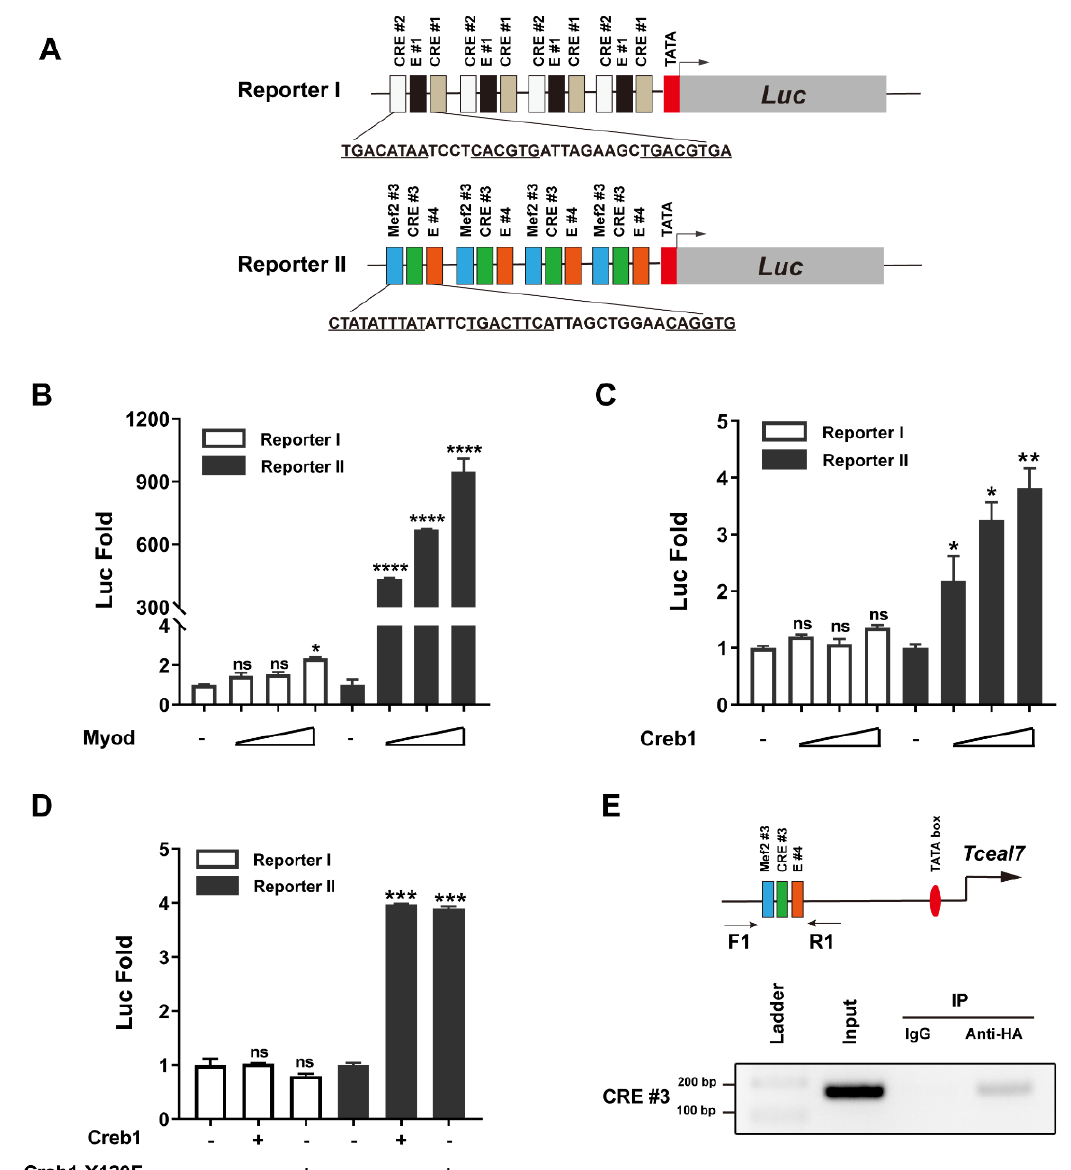
Figure 3. Transactivation of Tceal7 by Myod and Creb1. ( A ) Schematic illustration of Reporter I and Reporter II. Reporter I and Reporter II contain multimerized sequences from the Tceal7 promoter in a tandem manner: 4×(CRE#2–E#1–CRE#1) and 4×(Mef2#3–CRE#3–E#4), respectively. ( B ) Reporter I or Reporter II (400 ng) and Myod (200 ng, 400 ng and 600 ng) were cotransfected into the HEK293T cells, and analyzed with a dual-luciferase assay system. Myod can transactivate Reporter II up to 949-fold in a dose-dependent manner, while its transactivation of Reporter I is only 2.5-fold in HEK293T cells. * p < 0.05; **** p < 0.0001 and ns, not significant, comparison with first group (Reporter I or Reporter II). ( C ) Reporter I or Reporter II (400 ng) and Creb1 (200 ng, 400 ng and 600 ng) were cotransfected into the HEK293T cells, and analyzed with a dual-luciferase assay system. Creb1 can transactivate Reporter II up to 4-fold, but not Reporter I in HEK293T cells. * p < 0.05; ** p < 0.01 and ns, not significant, comparison with first group (Reporter I or Reporter II). ( D ) Creb1-Y120F or the wild-type Creb1 can transactivate Reporter II up to 4-fold, but not Reporter I in HEK293T cells. *** p < 0.001 and ns, not significant, comparison with first group (Reporter I or Reporter II). ( E ) Upper panel, ChIP primer design as in Figure 2D. Creb1 binds to the CRE #3 motif within the promoter of Tceal7 in C2C12 myotubes. All data are shown as mean ± S.D from three